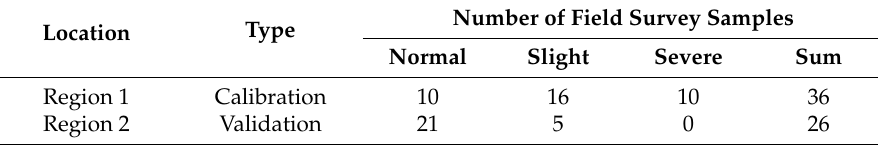
Figure 1. Geographic location and spatial distribution of wheat areas and sample points. Table 1. Basic information for the disease survey experiment.